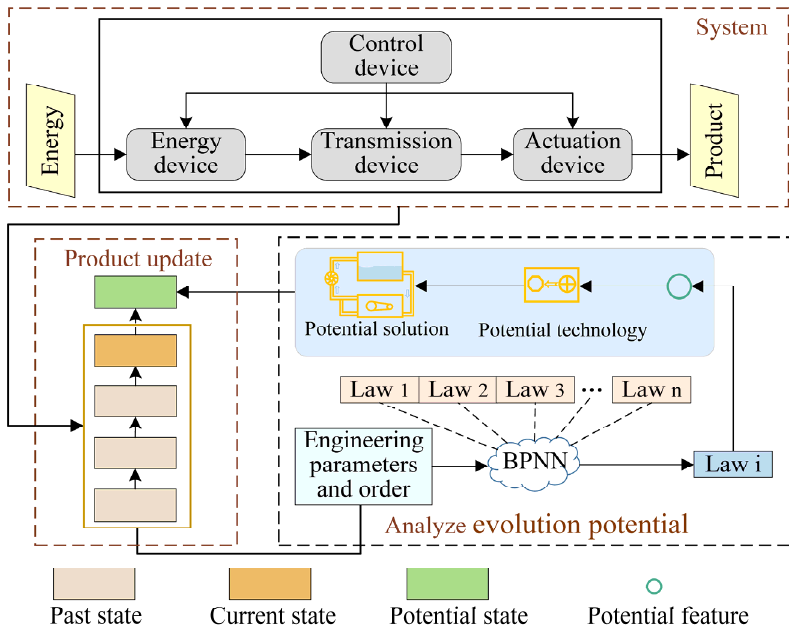
Figure 2. Acquisition of potential state.